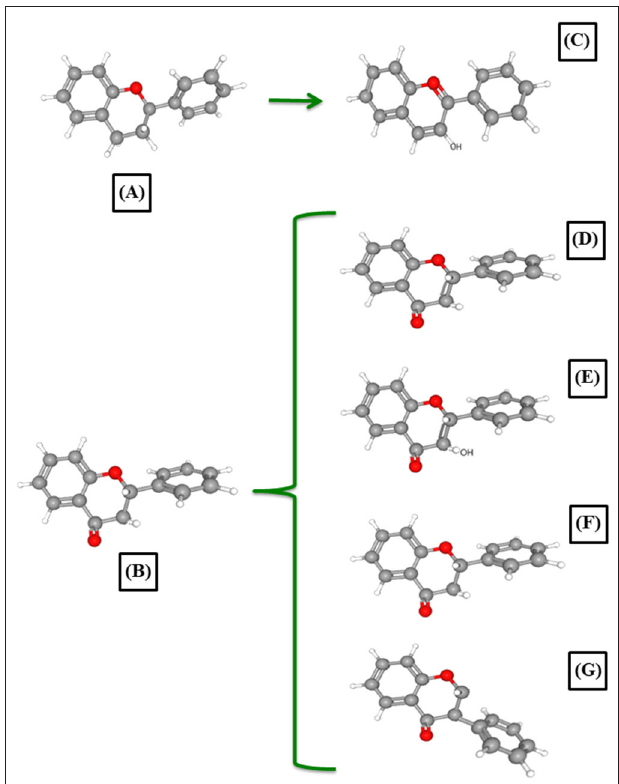
FIGURE 3 | The diverse structure and classification of major plant flavonoids: (A) flavan nucleus; (B) 4-oxo-flavonoid nucleus; (C) anthocyanidins; (D) flavones; (E) flavonols; (F) flavanones; and (G) isoflavones. The presented polyphenols within the mentioned figure are simplified, but show the complexity and diversity of major plant flavonoids. More in-depth depiction of polyphenols was published most recently ( Hassan et al.,